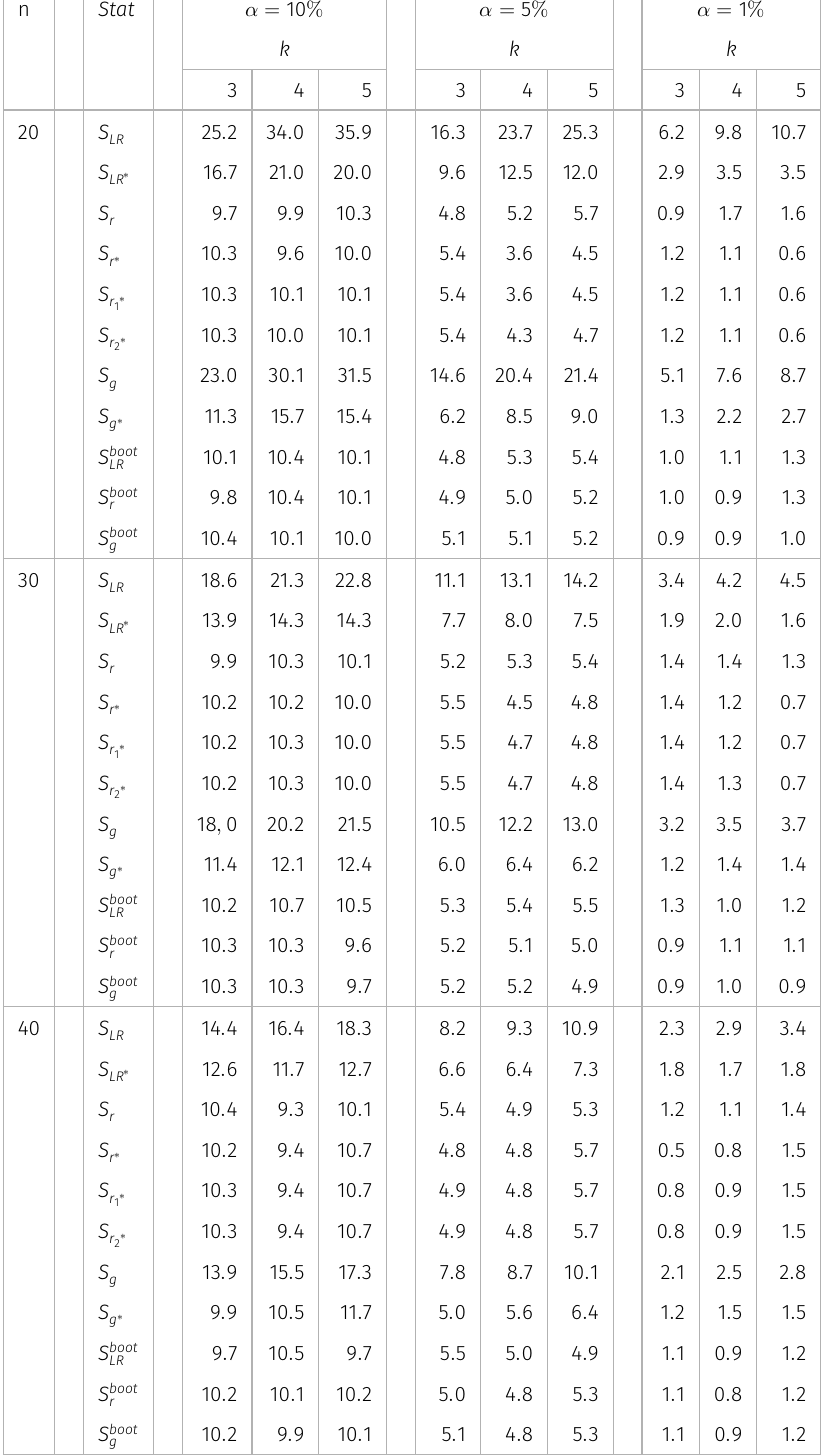
∶ 𝛿 = … = 𝛿 = 0 with p = 3 ; power exponential 𝜈 = 0 . 3 0 1 k